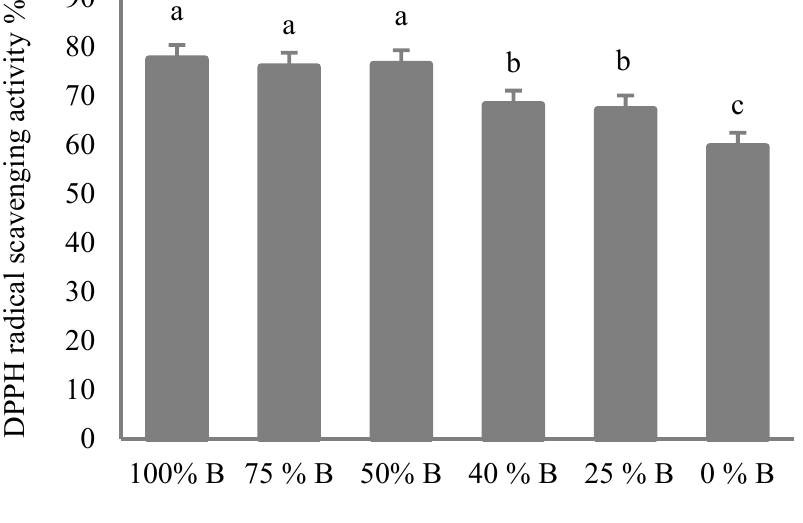
Figure 9. Antioxidant capacity of saffron plants grown under different ratios of Blue (B) to Red (R) light in the overall spectral composition, including 100% B, 75% B, 50% B, 40% B, 25% B, 0% B (see the spectrum in Figure 1), with 150 ± 10 µ mol m − 2 s − 1 PPFD. Different letters indicate that values are significantly different at p < 0.01 according to Duncan’s multiple range tests. Bars represent mean value ± standard deviation.